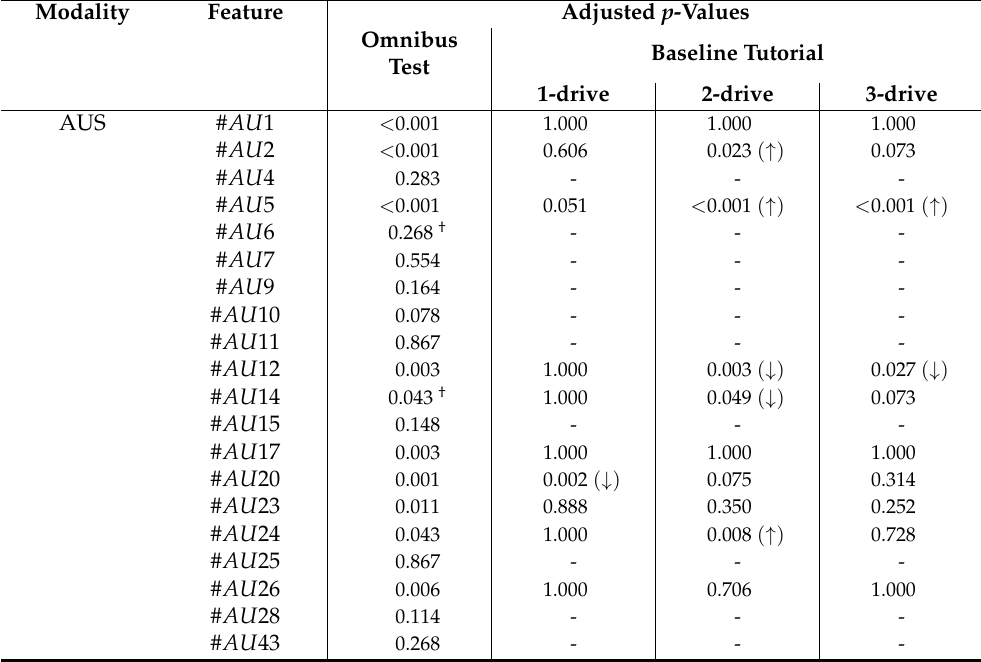
Table 7. Changes in action units during k data distribution shift between single (1-drive) and dual-task (2/3-drive)